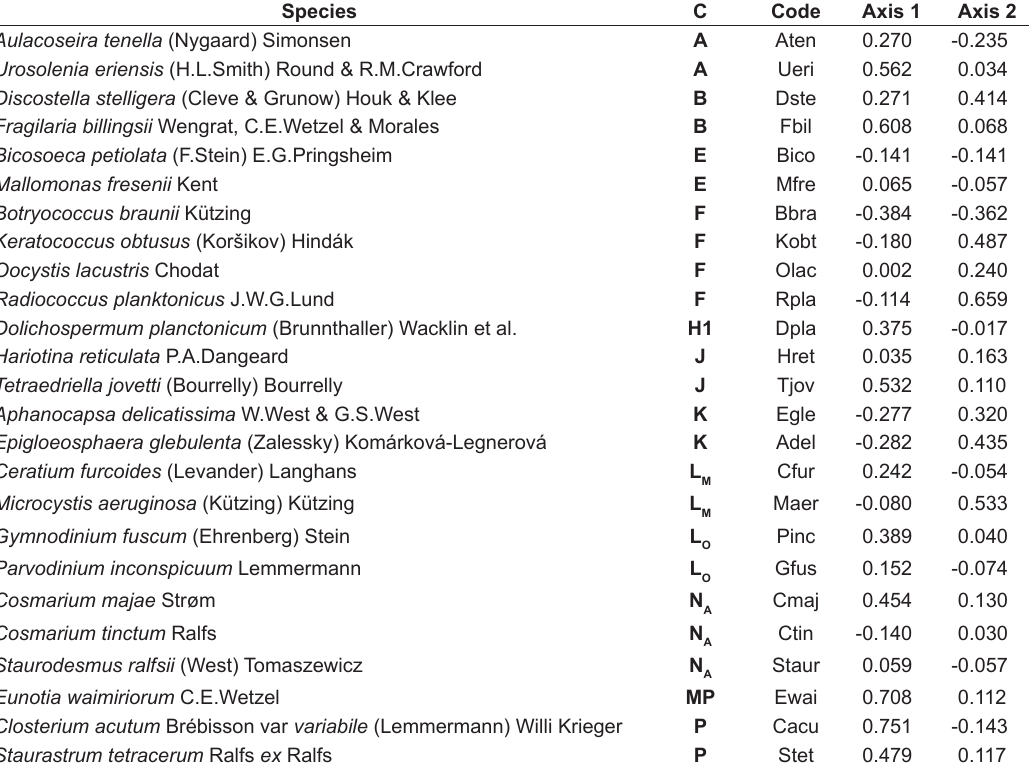
Figure 5. Redundancy analysis of phytoplankton species biomass (37 species) and environment variables (5 variables) in the three studied reservoirs. Abbreviations: capital letters indicate reservoir (FR Cachoeira do França, FU Cachoeira da Fumaça, SE Serraria), number indicates sampling site (1, 2, 3, 4), lowercase letter indicates sampling depth (s subsurface, m intermediate layer, b 1 m above bottom), and last capital letter indicates season of the year (S Summer, W Winter). Vectors: NO3 Nitrate, Secchi Secchi Disk, Temp Temperature, TP total phosphorus, TN Total Table 3. Descriptive species used to study community structure in the three reservoirs studied.